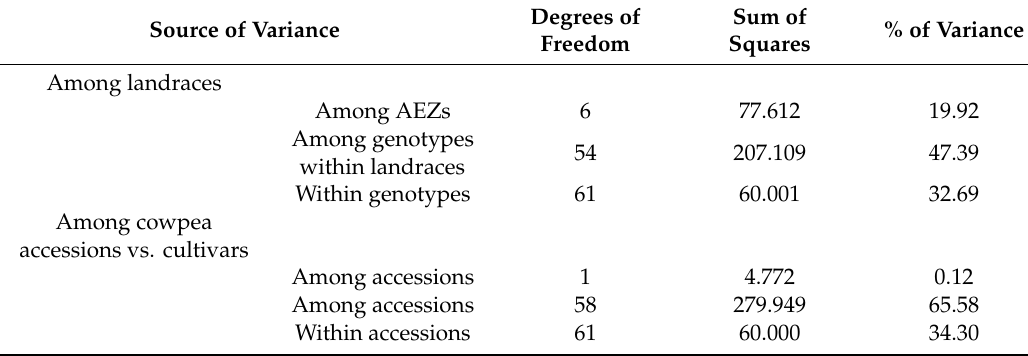
Table 3. Analysis of molecular variance (AMOVA) for the sampled landraces of Vigna unguiculata